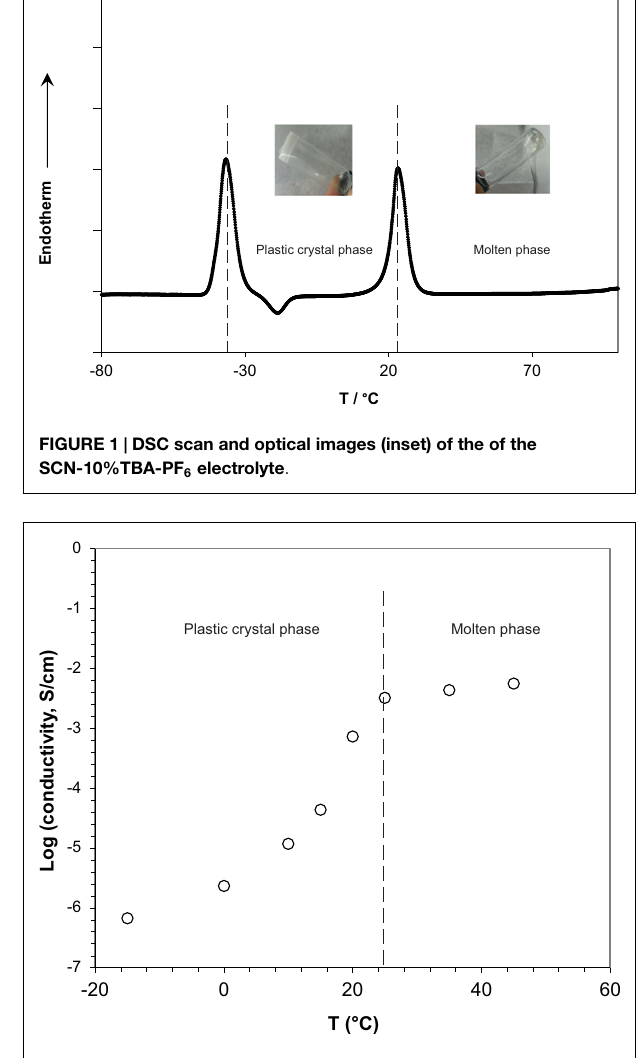
FIGURE 2 | Temperature-dependence of the conductivity of the SCN-10%TBA-PF 6 electrolyte